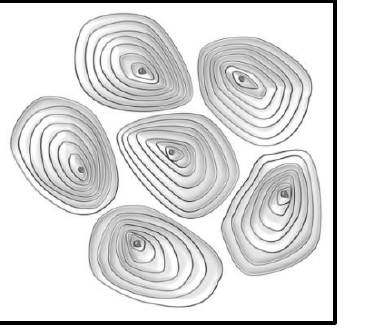
ε (cid:48) compared with the native-Rs from 5 Hz–5 MHz. This is because the